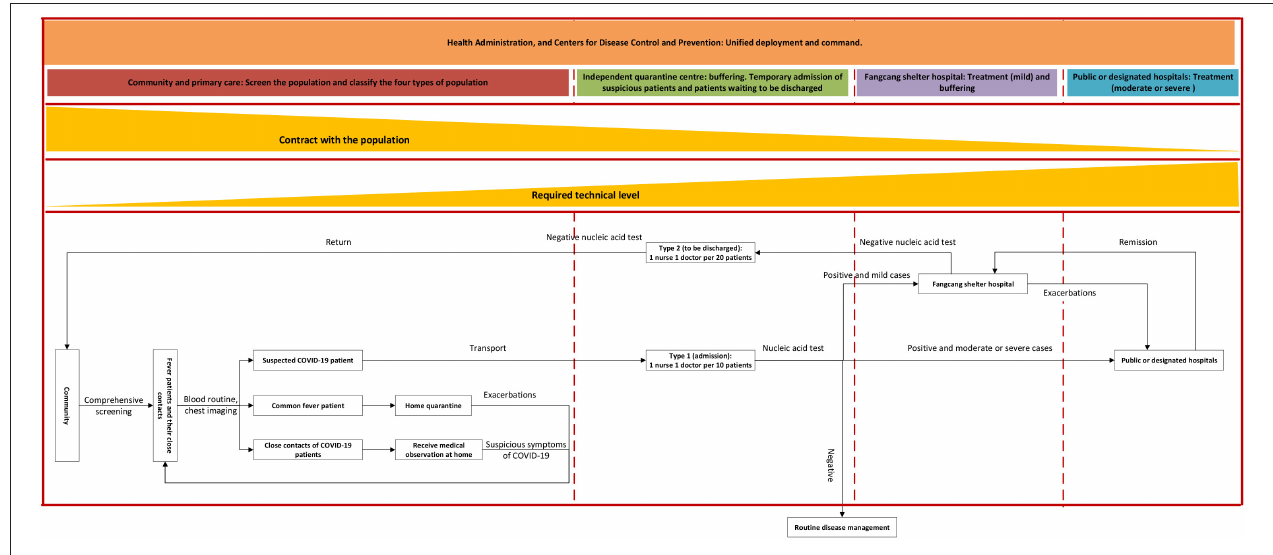
FIGURE 2 | Multi-agent cooperation model of COVID-19 preventing and controlling in